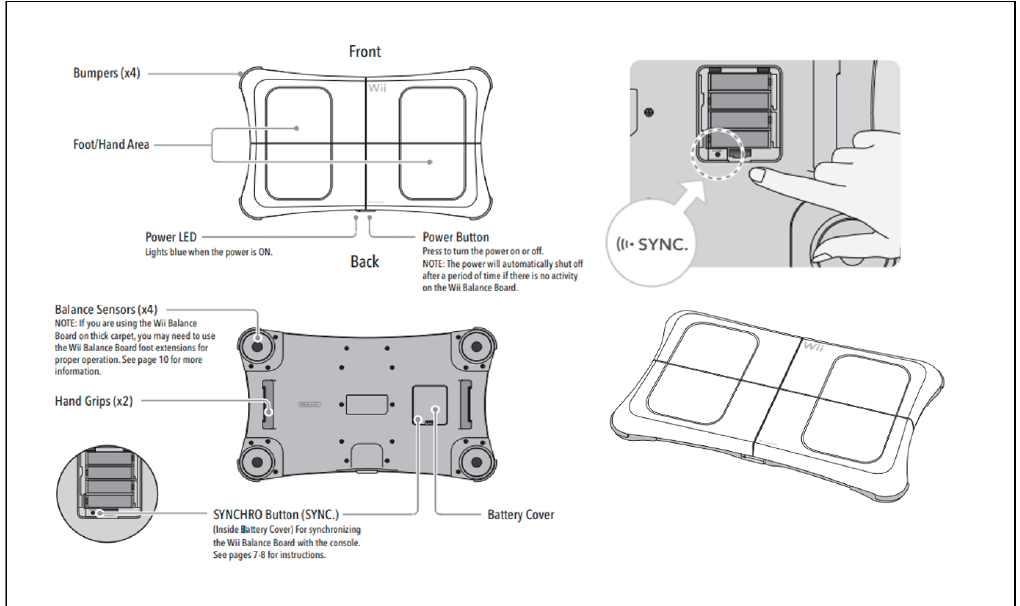
Figure 1. Components and structure of the WBB (from the Operations Manual).